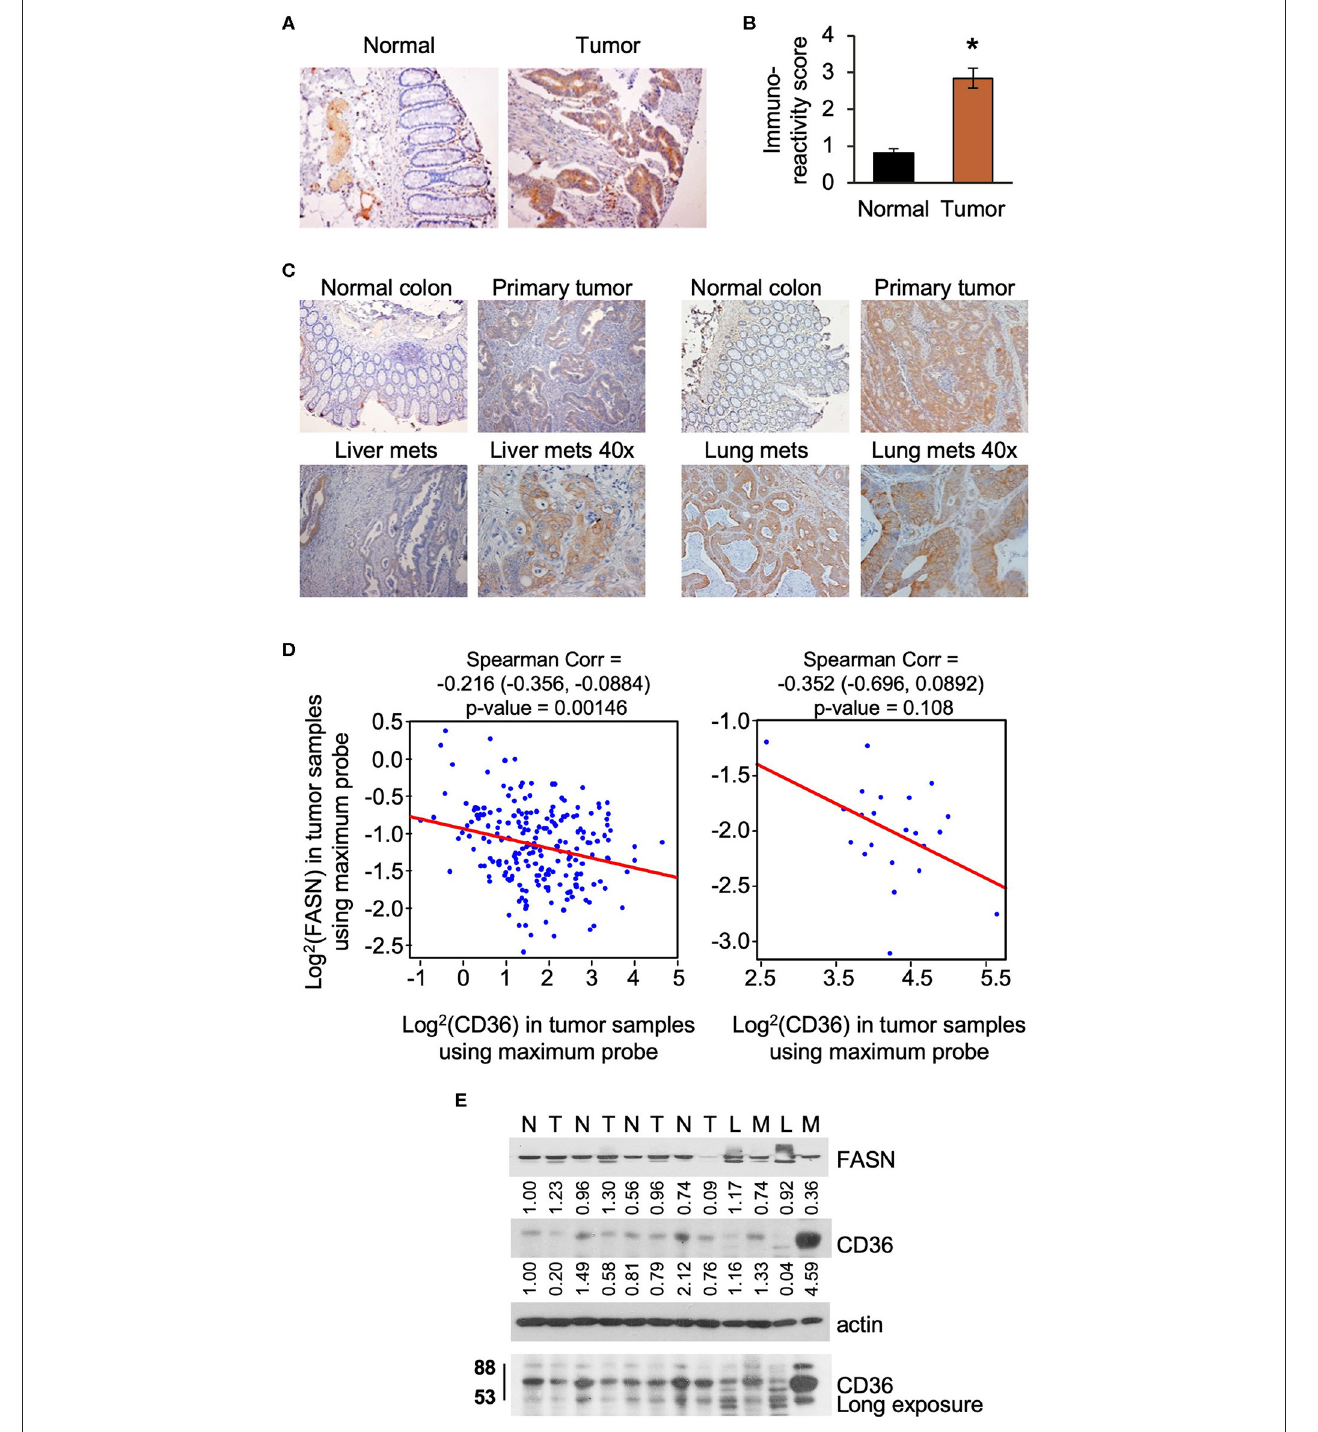
FIGURE 1 | CD36 is overexpressed in human CRC. (A,B) Immunoreactivity score of CD36 expression was analyzed in matched normal colon mucosa and tumor tissues from patients diagnosed with Stage I–IV CRC (TMA: n = 56, * p < 0.001 vs. normal tissue). (C) CD36 staining in matched normal colon mucosa, primary CRC, and CRC metastasis to liver and lung [representative images are shown; liver ( n = 12) and lung metastasis ( n = 5)]. (D) Correlations between FASN and CD36 was determined based on RNASeq data of CRC patient samples ( n = 22 of normal tissues and n = 215 of tumors) from The Cancer Genome Atlas. (E) Expression of FASN and CD36 in human normal colon mucosa and tumor tissues. N, normal mucosa; T, primary tumor; L, normal liver tissue; M, liver metastasis.